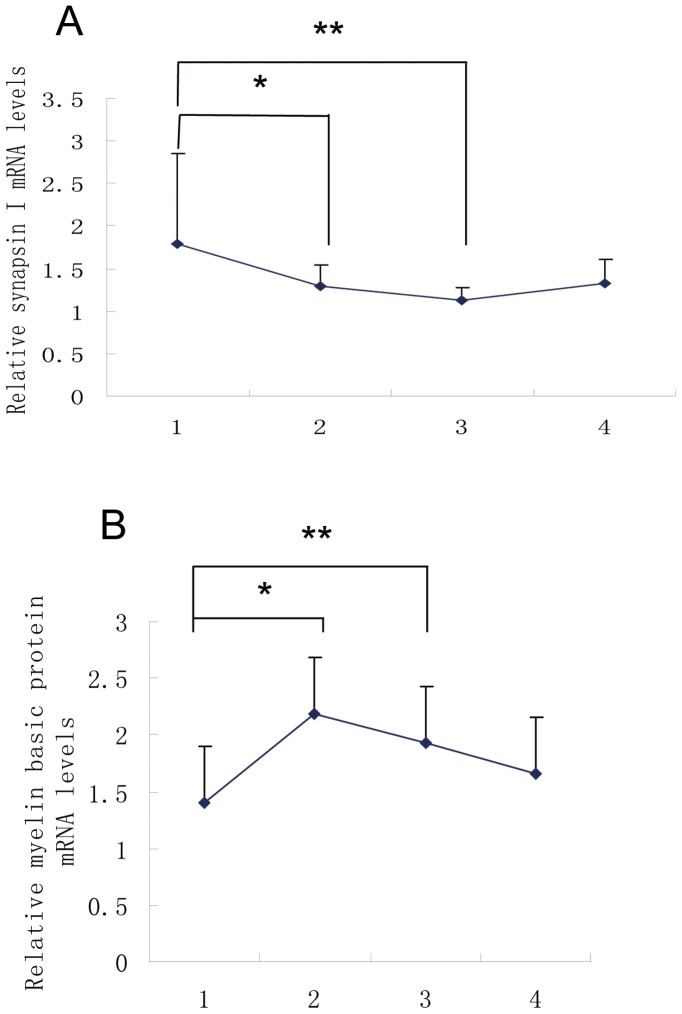
Blots of qRT-PCR assays for the mRNA levels of synapsin-1 and myelin basic protein (MBP) genes in the medulla of SHRs.Lane 1, model group; lane 2, normal group; lane 3, Taichong group; and lane 4, non-acupoint group. *P<0.05; **P<0.01.